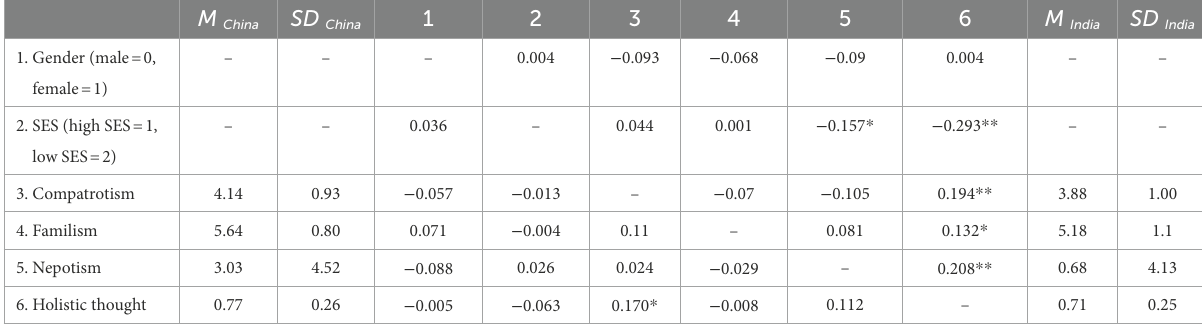
TABLE 2 Descriptive statistics and the internal correlations among the variables for Chinese (below the diagonal)and Indians (above the diagonal).